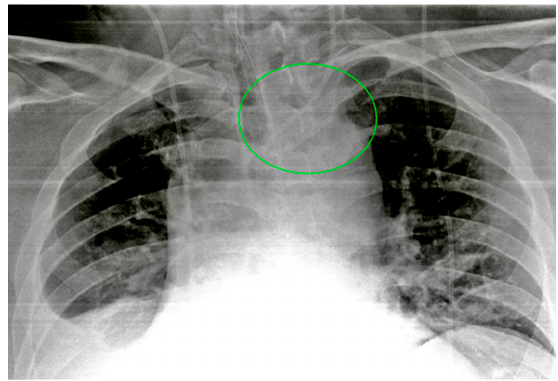
Figure 5. A detail of a CXR showing a left jugular CVC looping with tip ending in the left jugular vein (green circle). Note that due to the underexposure of the CXR, the device is difficult to detect. Table 2. Intravascular devices’ most frequent CXR-detectable anomalies and complications.